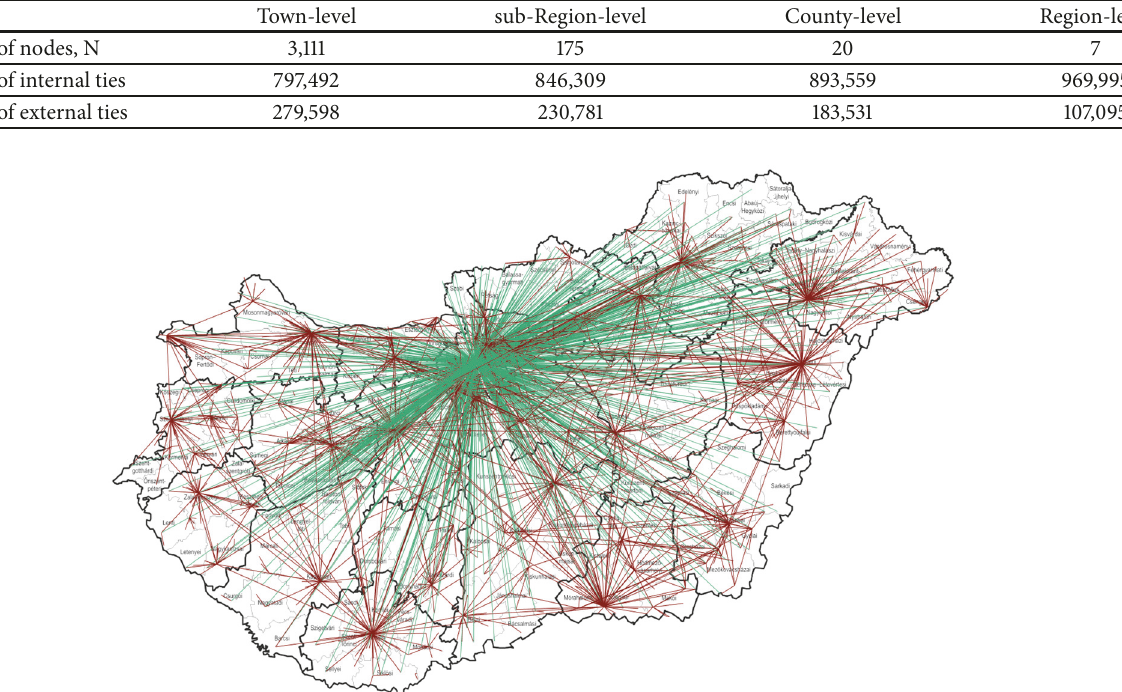
Figure 2: Map of the town-levelcompany-ownership network. Edges with more than 10 ownership connections are shown. Edges connected to the capital (Budapest) are denoted by green lines.